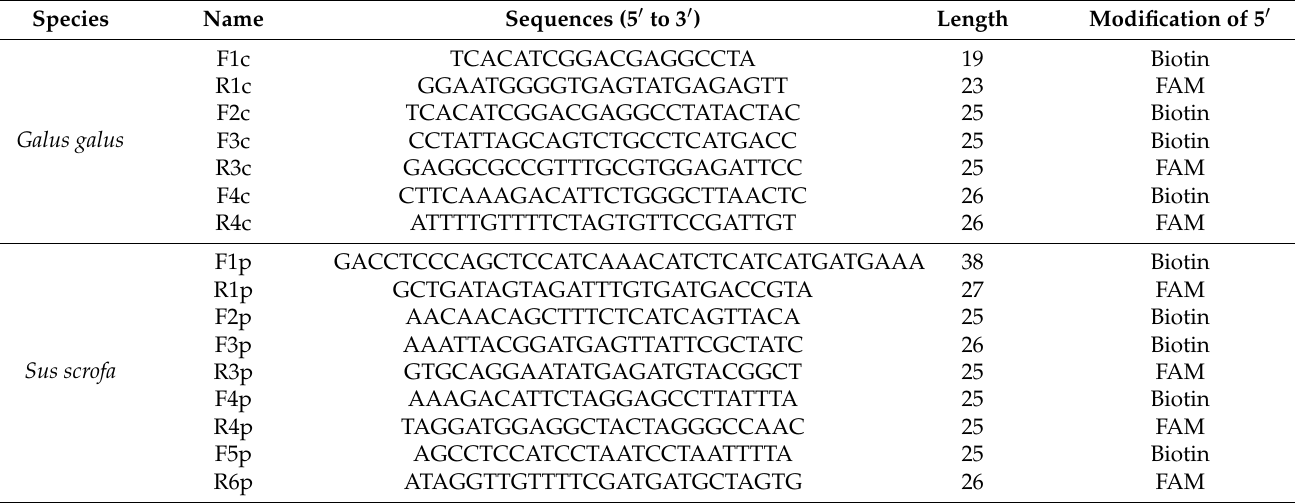
Table 1. Sequences of primers